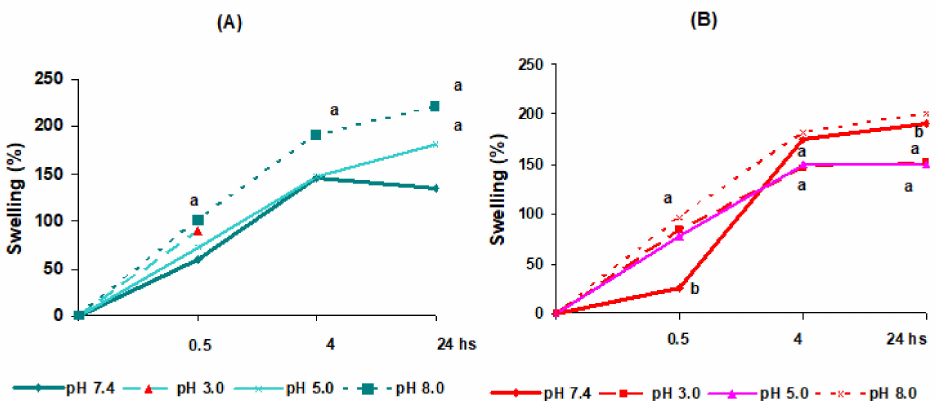
Figure 3. Swelling degree of AP4 ( A ) and HS4 ( B ) gel beads incubating in PBS of different pH for 24 h. The data are presented as the mean (n = 10). a p < 0.05 vs. PBS pH 7.4; b p < 0.05 vs. the corresponding AP4 gel beads.